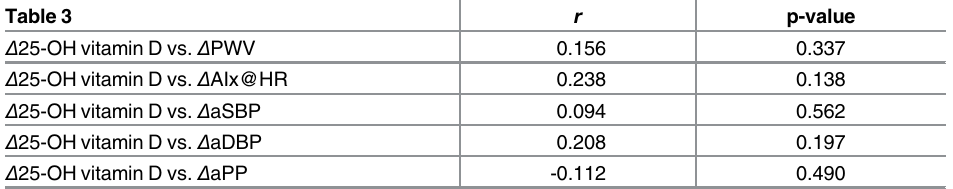
Table 3. Correlations between 25-OH Vitamin D and Vascular Stiffness and 24-hour Ambulatory Blood Pressure. Table 3 r